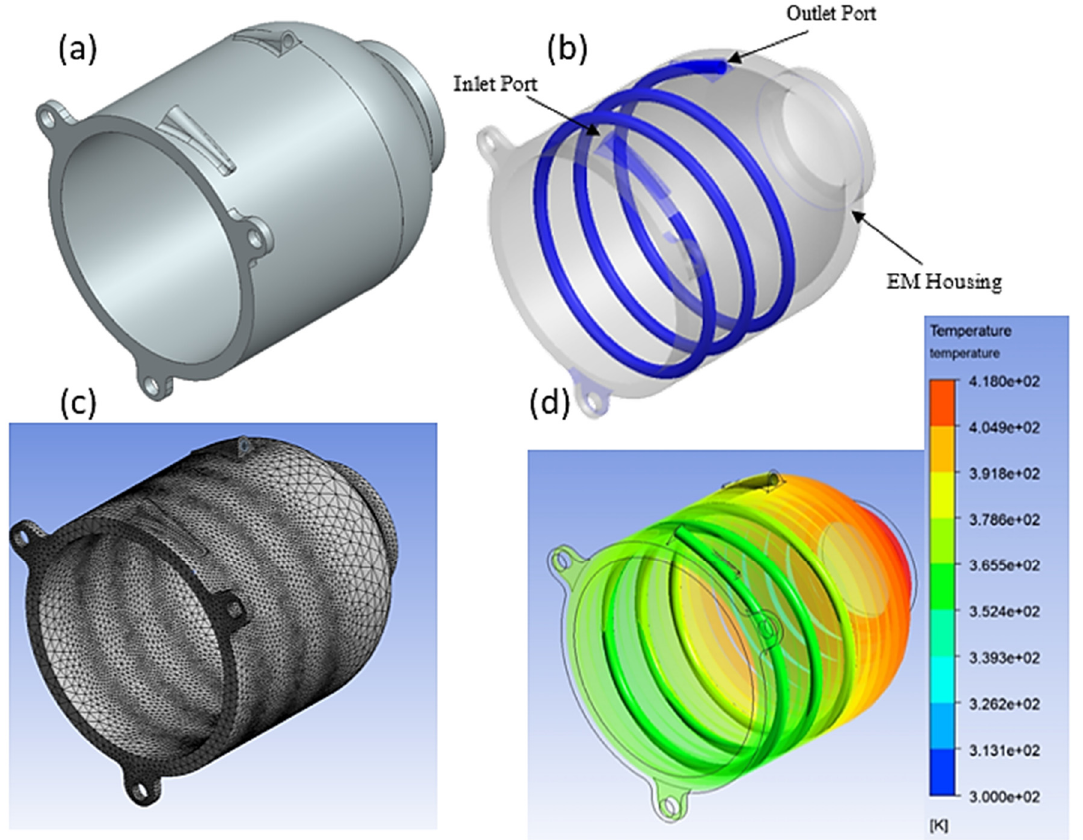
Figure 8. ( a ) CAD Geometry–EM housing. ( b ) CAD Geometry of helical water-cooling jacket. ( c ) Helical water jacket geometry meshing. ( d ) Motor housing temperature distribution with helical water